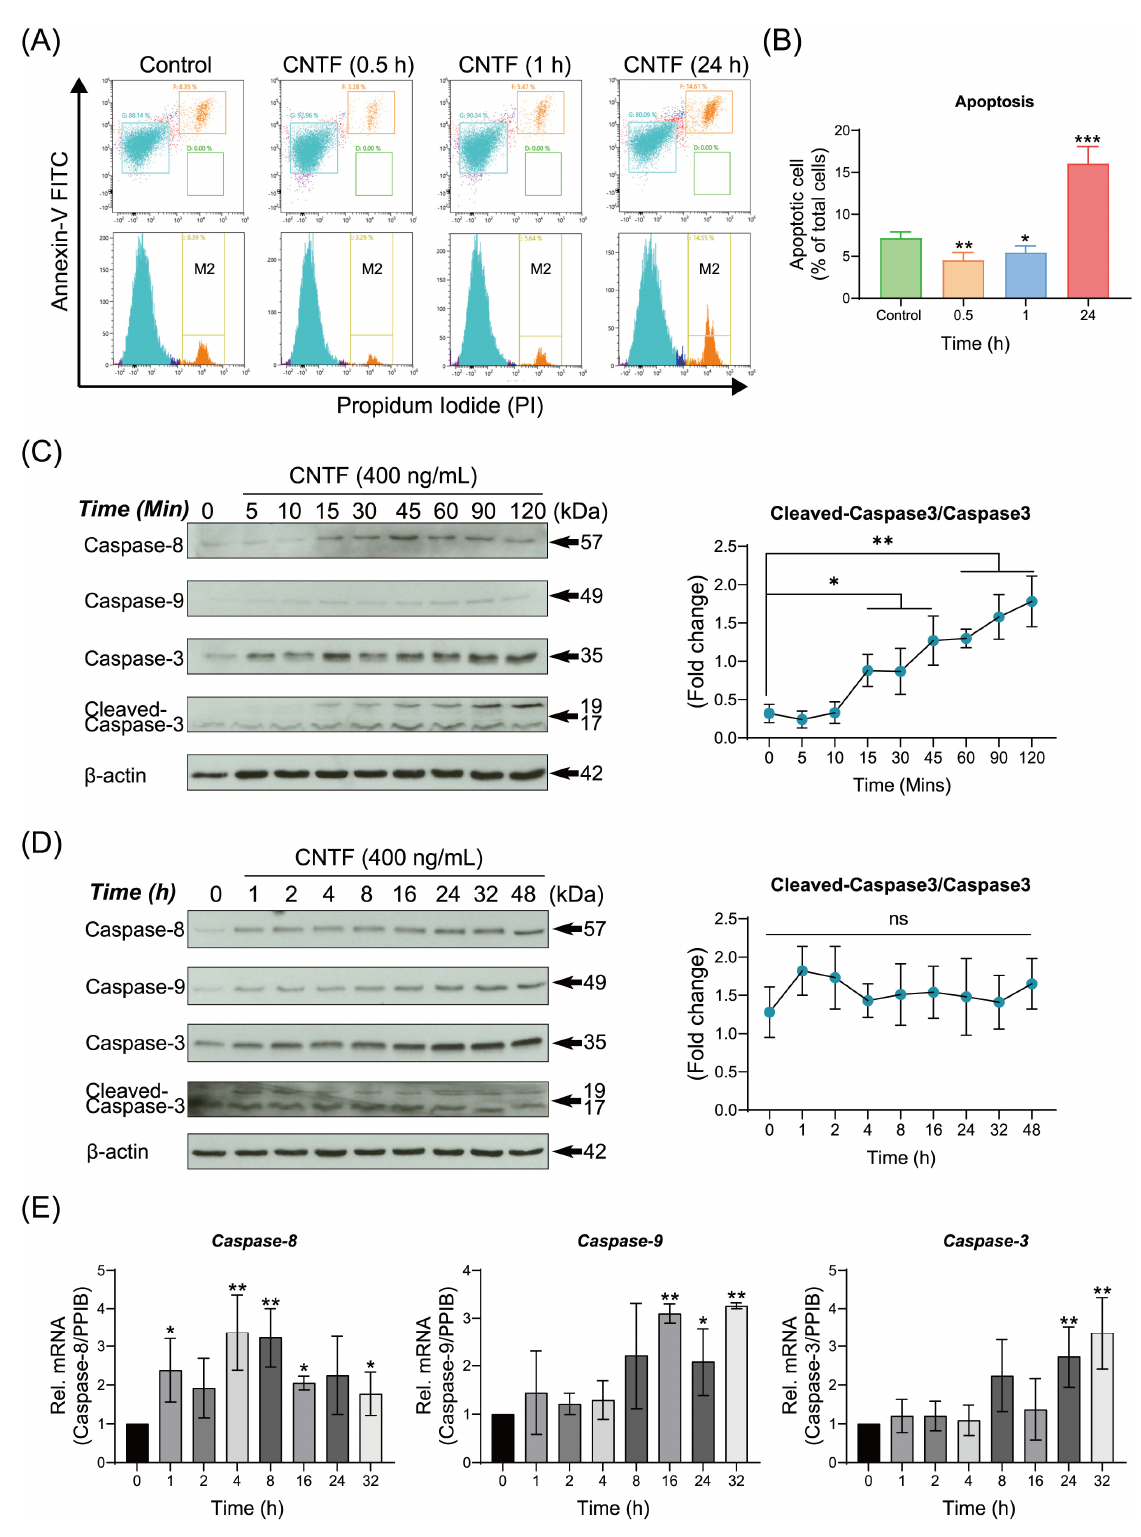
Figure 4. Ciliary neurotrophic factor regulates apoptosis rate and triggers the caspases signaling. ( A , B ) Representative plots from Annexin-V FITC and PI staining by flow cytometry analysis performed in triplicate are shown. Apoptotic cells (Annexin-V FITC + /PI + ) are shown in the upper right quadrant. Graphics show the percentages of apoptotic cells exposed to CNTF (400 ng/mL) at different time periods. ( C , D ) Representative immunoblot showed that the protein expression of Caspase-8, -9 and -3 as well as cleaved-caspase-3 in response to CNTF (400 ng/mL) in a time-dependent manner. β -actin was loaded as an internal control. ( E ) mRNA expression of Caspase-8 , -9 and -3 in response to CNTF (400